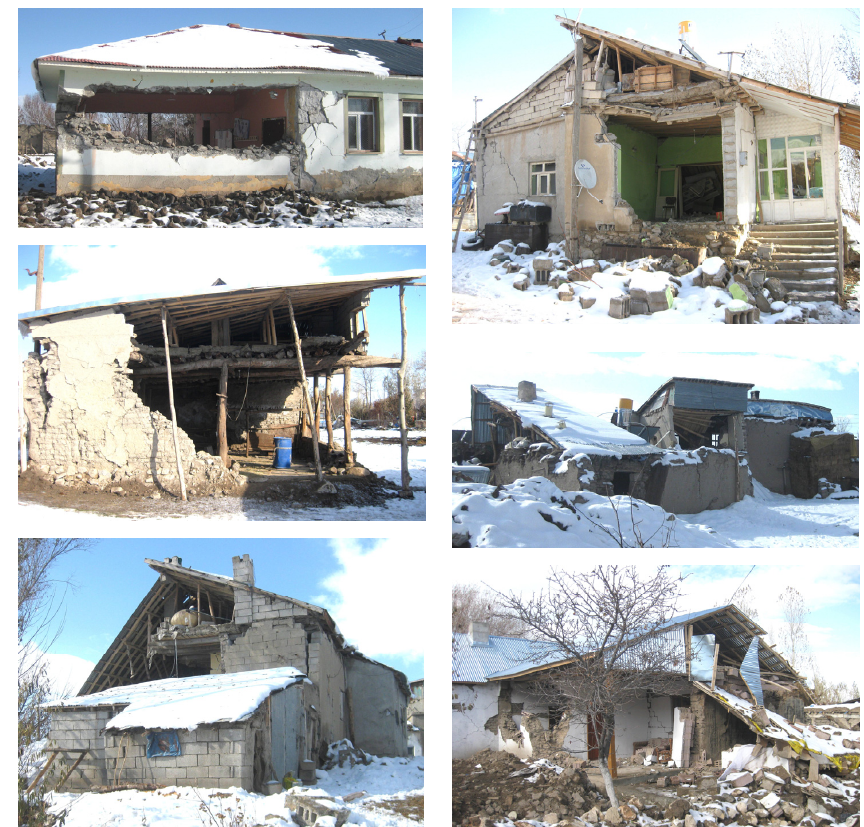
Fig. 5. Various types of damages observed at URM buildings after the 2011 Van earthquakes.